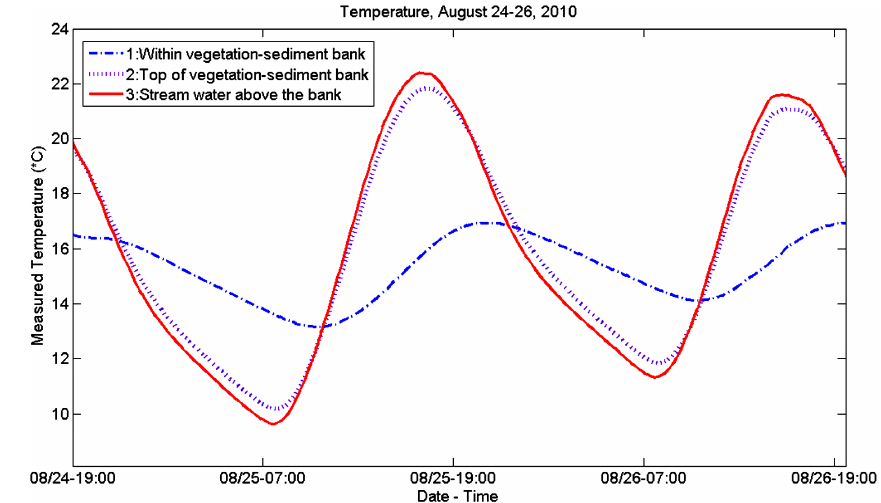
Figure 3. Two days of point temperature measurements from above, within and below the vegetation–sediment layer.